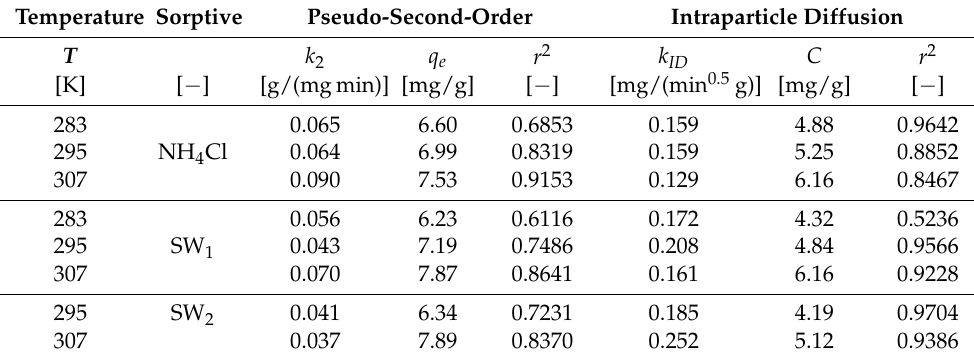
Table 7. Coefficients of the sorption kinetics according to the PSO and ID models of CCP 20 at different temperatures (283–307 K, specific sorbent ratio: 0.1 g CLI /mg NH4 − N ; NH4Cl solution: c 0 = 1000